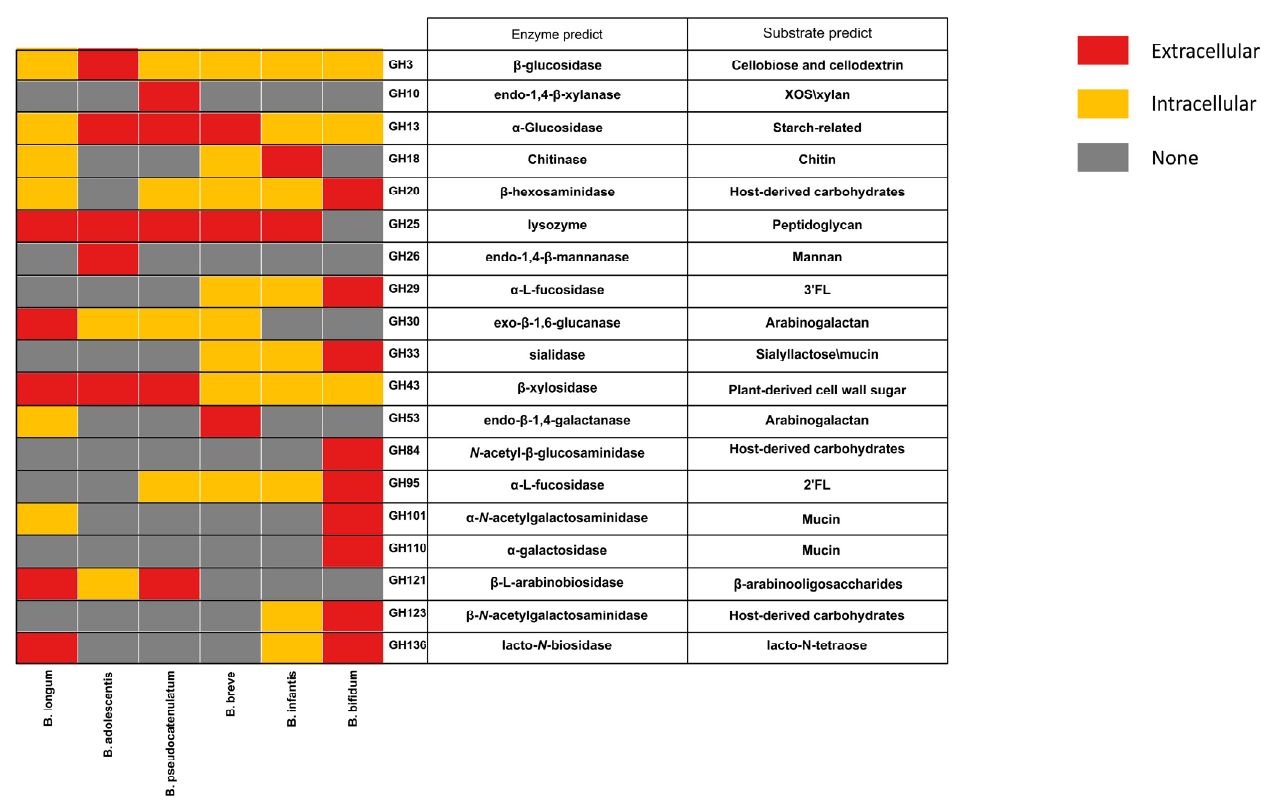
Figure 4. Distribution characteristics of predicted extracellular GHs across Bifidobacterium .